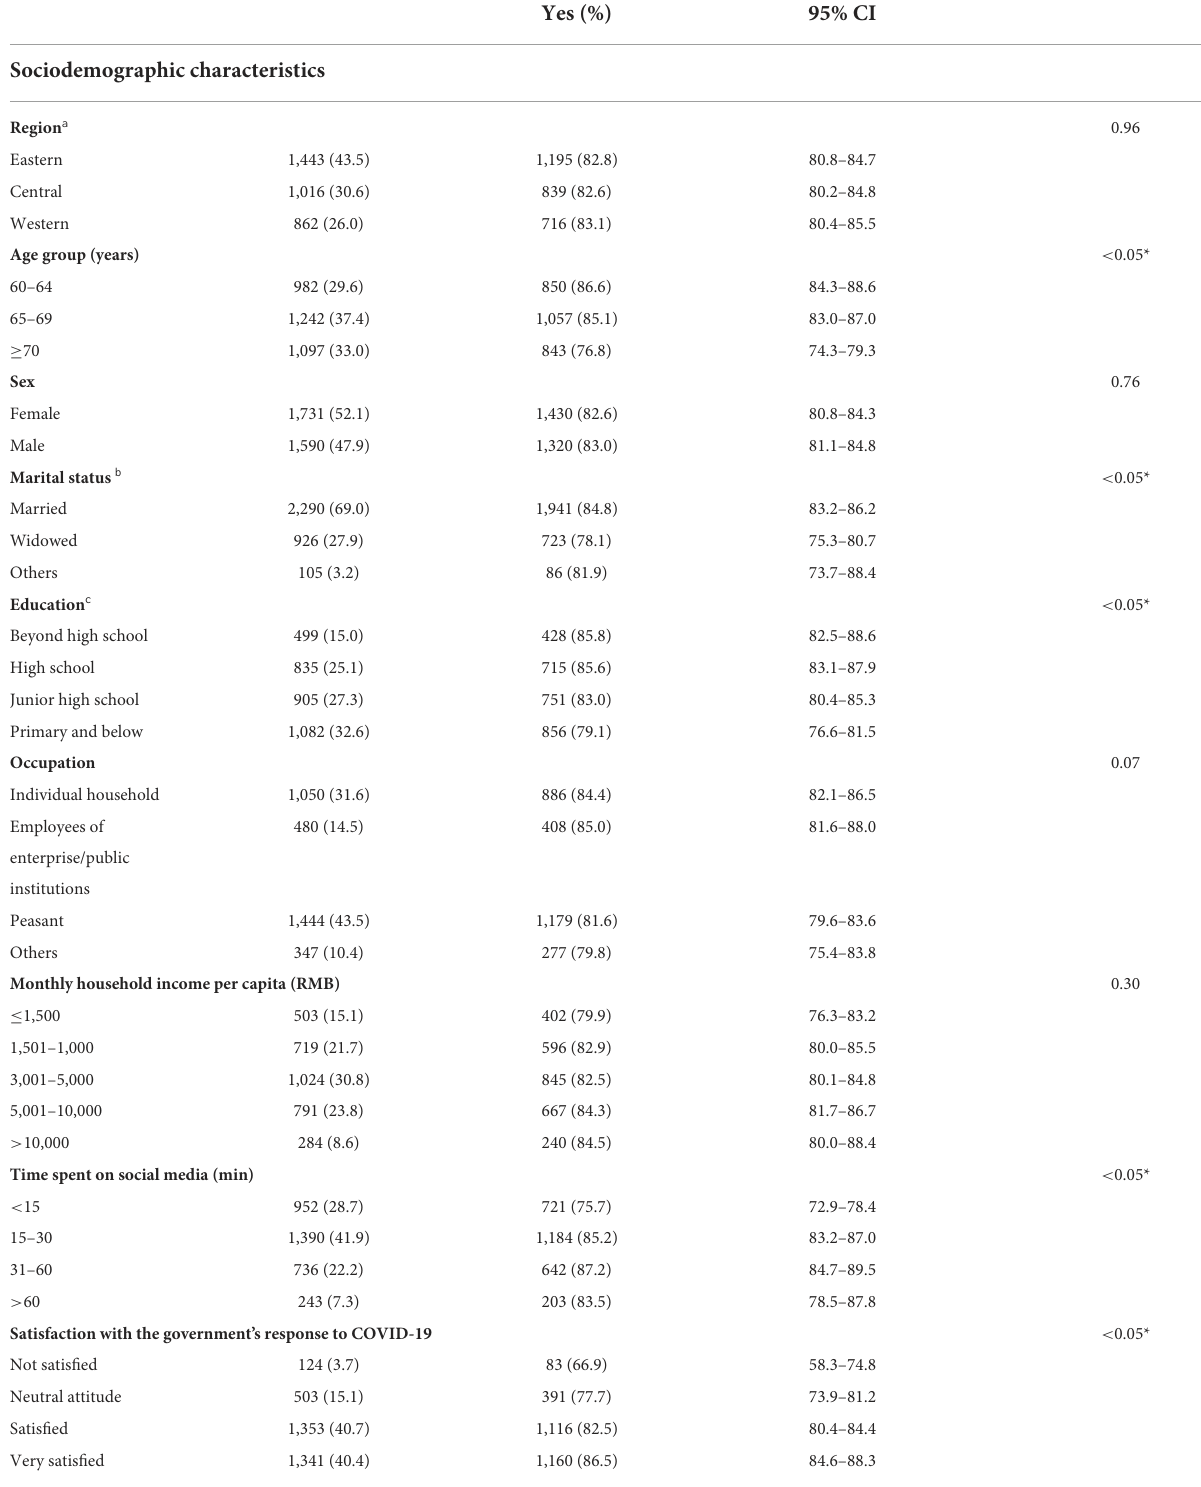
TABLE 1 Acceptance of a COVID-19 vaccine booster dose among older adults in China by demographic characteristics ( n = 3,321). Characteristics Number (%) Acceptance of a COVID-19 vaccination booster dose P Yes (%) 95% CI Sociodemographic